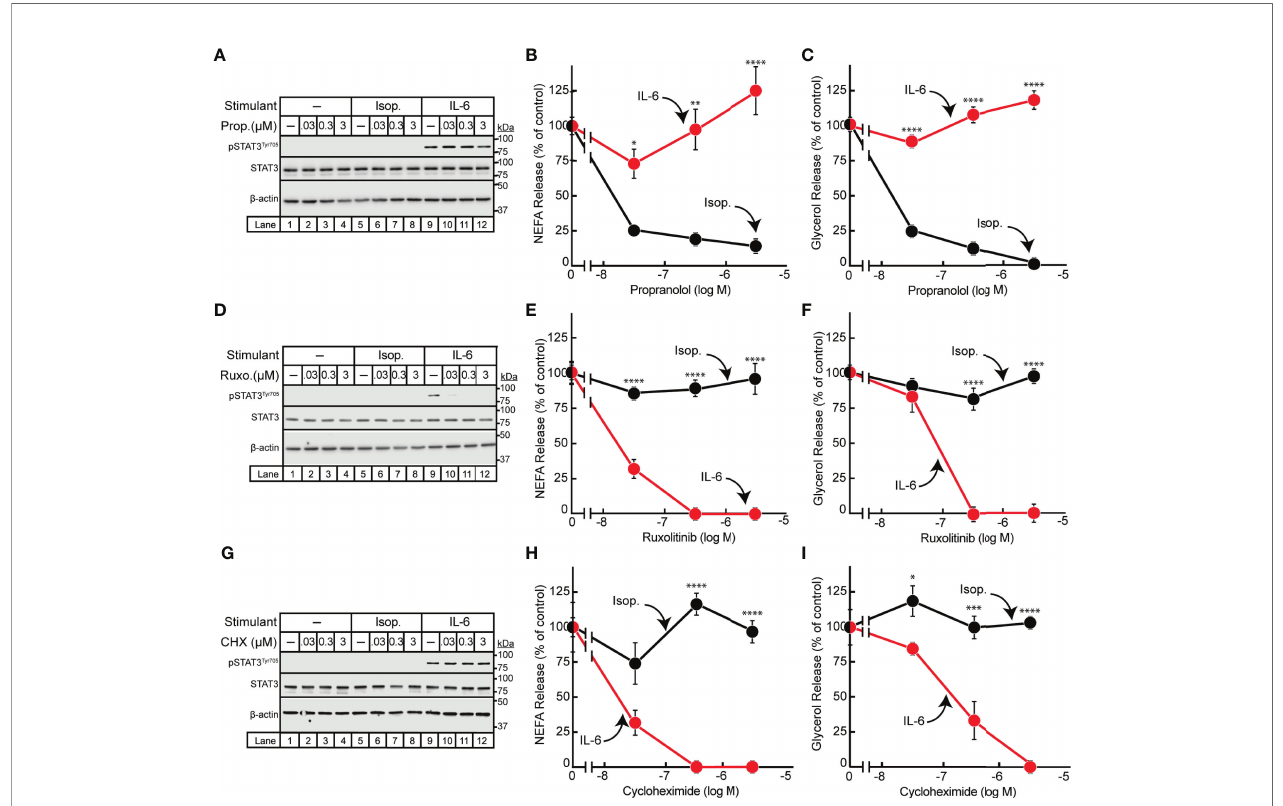
FIGURE 2 | Effect of Inhibitors on IL-6- and b -adrenergic-treated Adipocytes. (A – I) Differentiated adipocytes in a 12-well format were treated in a fi nal volume of 1 ml medium D with 6 µl DMSO and 3 µl PBS containing either 10 nM isoproterenol ( black, Isop. ) or 3 nM IL-6 ( red ) in the absence or presence of the indicated concentration of propranolol ( A – C , Prop. ), ruxolitinib ( D – F , Ruxo. ), or cycloheximide ( G – I , CHX ). After incubation for 24 hours, medium was collected and processed to measure concentrations of NEFA (B, E, H) or glycerol (C, F, I) and adipocytes were harvested and processed for immunoblot analysis (A, D, G) with the indicated antibodies as described in Methods . Data is shown as mean ± SEM of three wells. * p < 0.05, ** p < 0.01, *** p < 0.001, or **** p < 0.0001 based on two-way ANOVA followed by S ̌ ida ́ k ’ s multiple comparison test to compare isoproterenol to IL-6 conditions at matched time points. These results were con fi rmed in at least three independent of NEFA ( Figure 2H ) and glycerol ( Figure 2I ) release from IL-6-